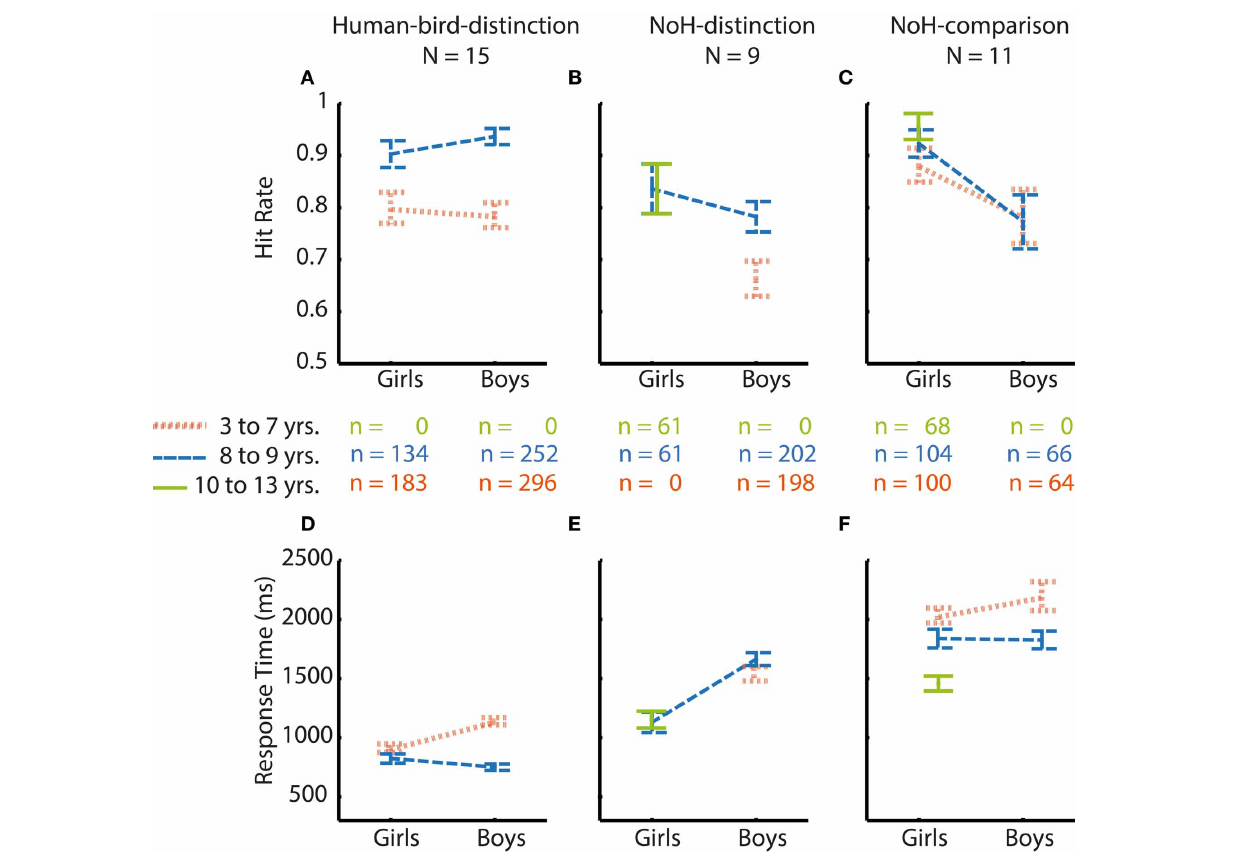
graph, boys’ responses on the right. Comparisons between age groups and genders are illustrated for Human-bird-distinction (left, A,D ), NoH-distinction (middle, B,E ) and NoH-comparison (right, C,F ) separately. N refers to the number of children, n to the number of trials. Error bars represent SEM.